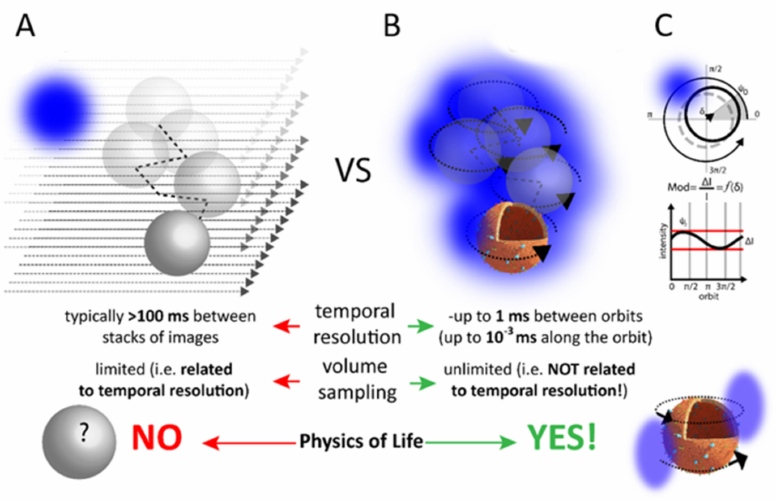
Figure 11. The orbital tracking approach. ( A ) The classical strategy of imaging subcellular nanos- tructures in 3D relies on probing the volume in a time-consuming target-search process. ( B ) The time resolution is not enough to grab (molecular) details on the structure of interest. By contrast, by forming a light envelope around the point of interest, the time resolution remains constant during the measurement (microseconds along the orbit, milliseconds in between orbits), and becomes suitable to study molecular processes on the target. ( C ) Modulation of signals detected along the orbit is kept at a minimum, i.e., the target is kept at the center of the